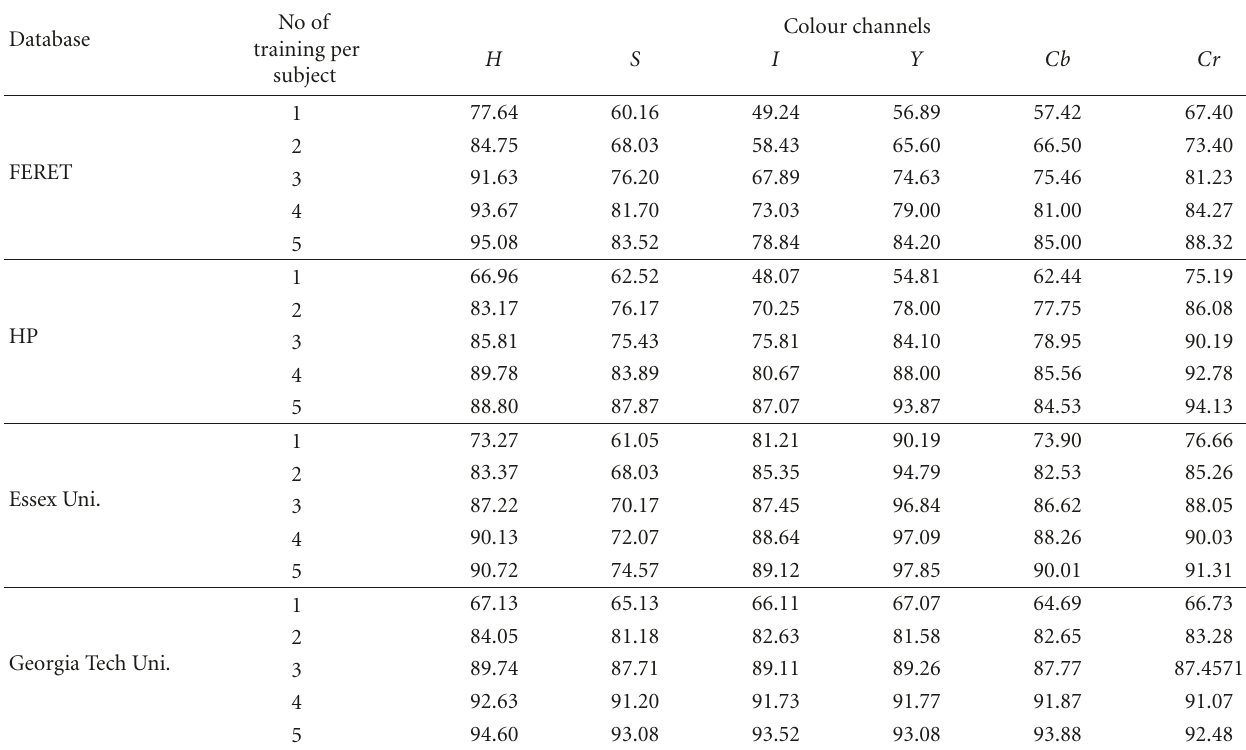
Table 2: Performance of the proposed PDF-based face recognition system in H , S , I , Y , Cb , and Cr colour channels of the FERET, HP, Essex, and Georgia Tech University face